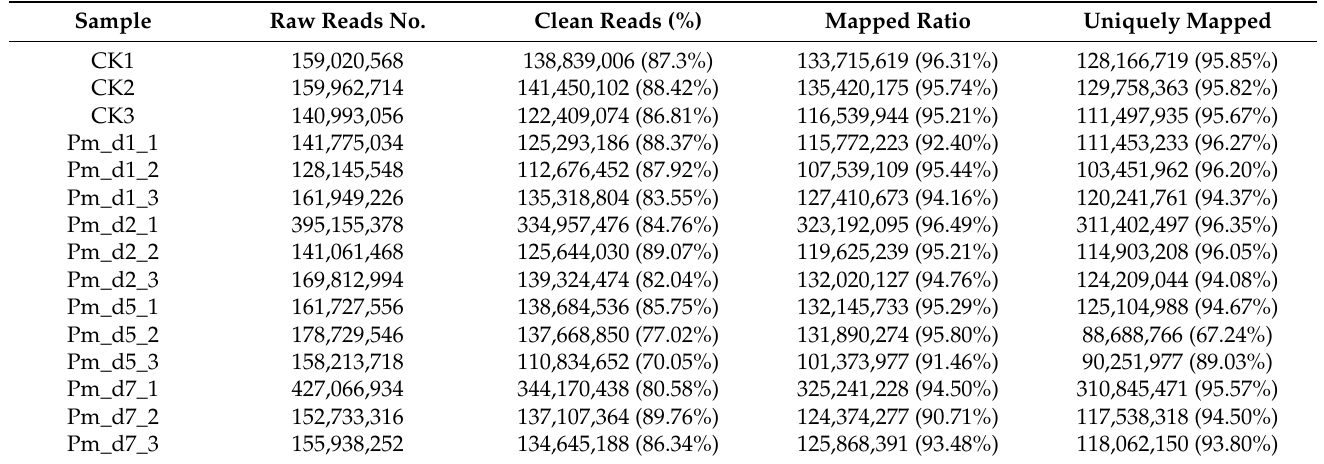
Table 2. Data showing statistical results of RNA-seq for goat lung tissues in the different groups. Sample Raw Reads No. Clean Reads ( % ) Mapped Ratio Uniquely Mapped